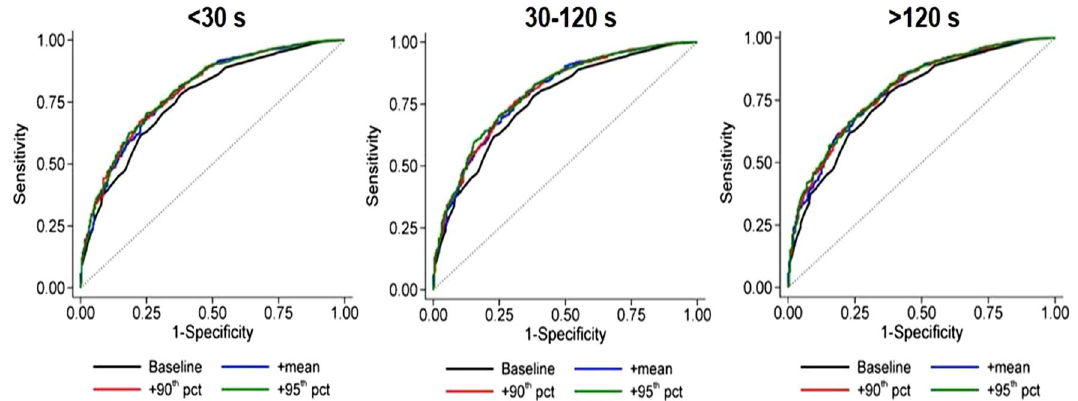
Figure 3. ROC of model A (baseline, i.e., without speed metrics) and B (baseline plus speed metrics: mean, + 90th, and + 95th percentile (pct)) in discrimination of frailty condition according to each bout duration, (CoLaus cohort, Lausanne, Switzerland,